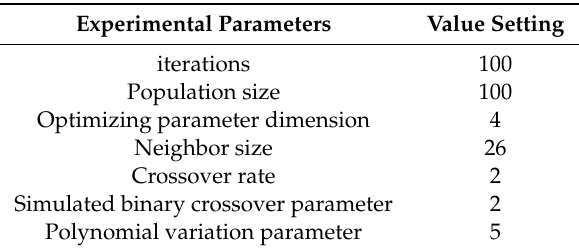
Table 10. Default settings of Multi-objective Evolutionary Algorithm based on Decomposition (MOEA /